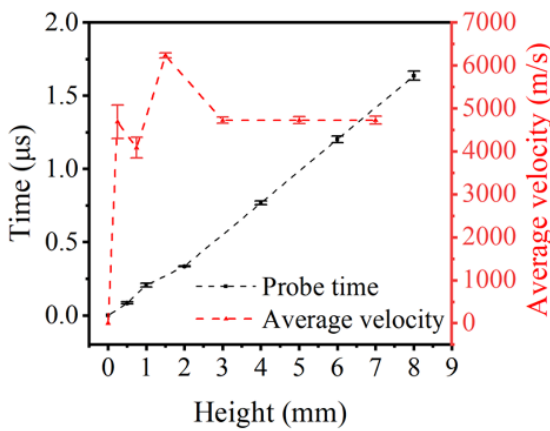
Figure 5. Probes signal time as a function of charge height and average velocity as a function of charge height.